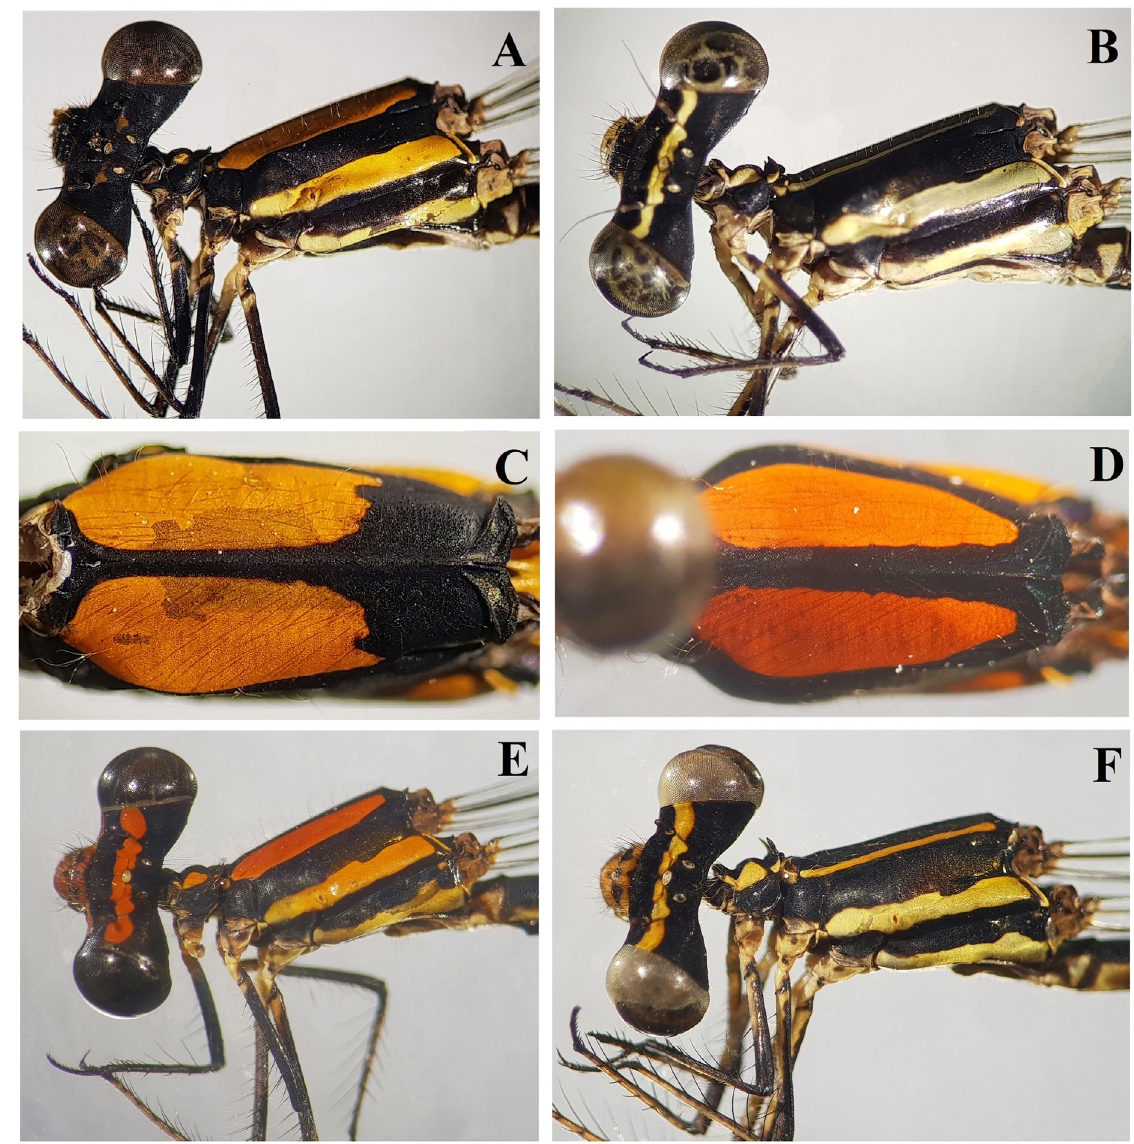
Fig. 6. Prodasineura Cowley, 1934 spp. A–C . P. croconota Ris, 1916, ZCDTU 2017060802-ODO. D–F . P. verticalis Selys, 1860, ZCDTU 2018030611-ODO. A, E = ♂, head and thorax, lateral view; C–D = ♂, synthorax, dorsal view; B, F = ♀, head and thorax, lateral view. Images not to